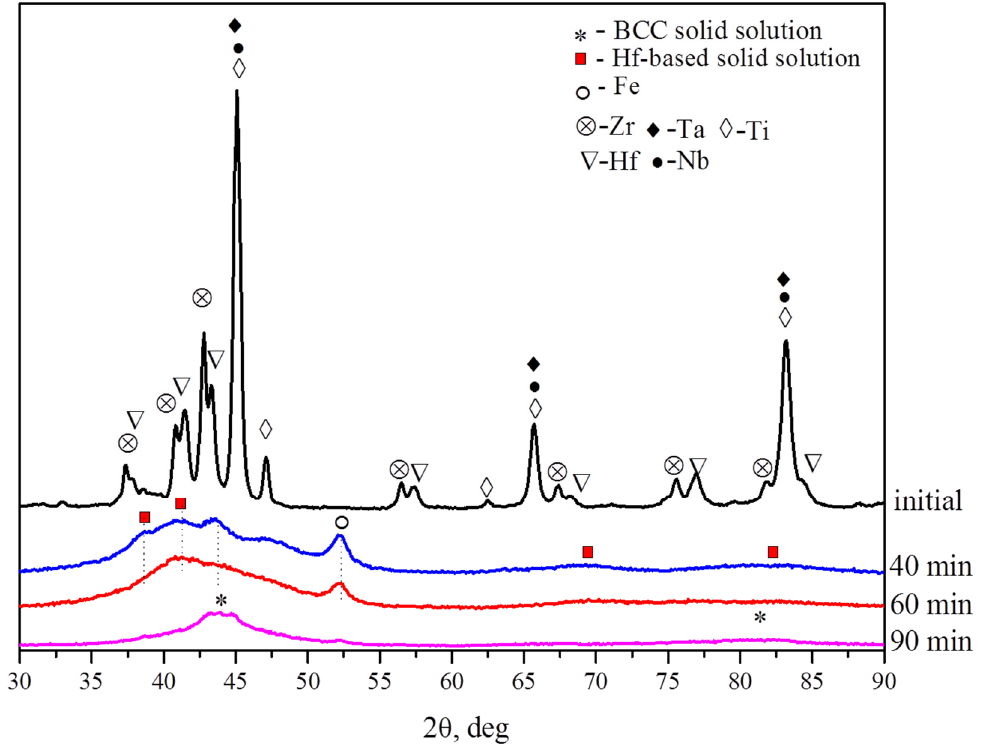
Figure 10. XRD patterns of HfTaTiNbZr powder mixtures taken after high-energy ball milling (HEBM) for different t (indicated on the right). The spectra are shifted along the y axis for the sake of clarity.